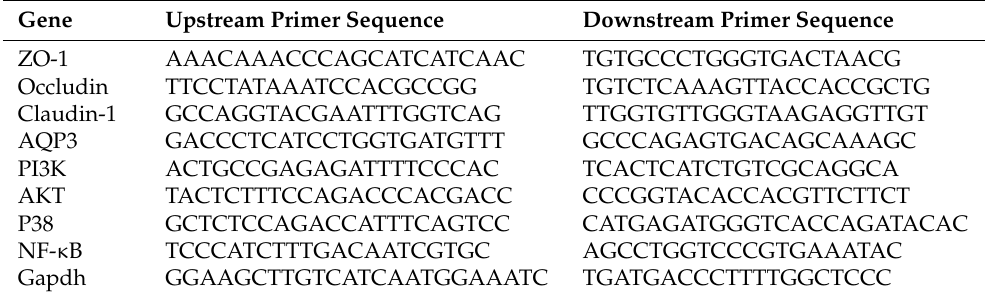
Table 1. The following mRNA primer sequences were used for reverse transcription-quantitative PCR. Gene Upstream Primer Sequence Downstream Primer Sequence